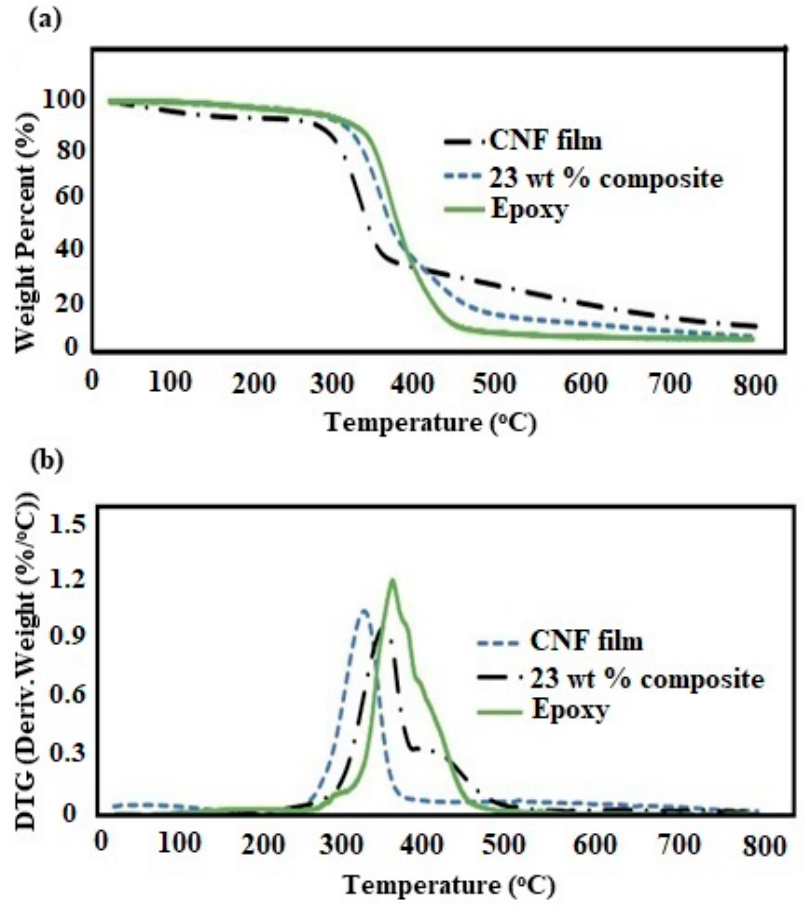
Figure 7. ( a ) TGA and ( b ) DTG curves for pure CNF, epoxy, and the 23 wt % composite.